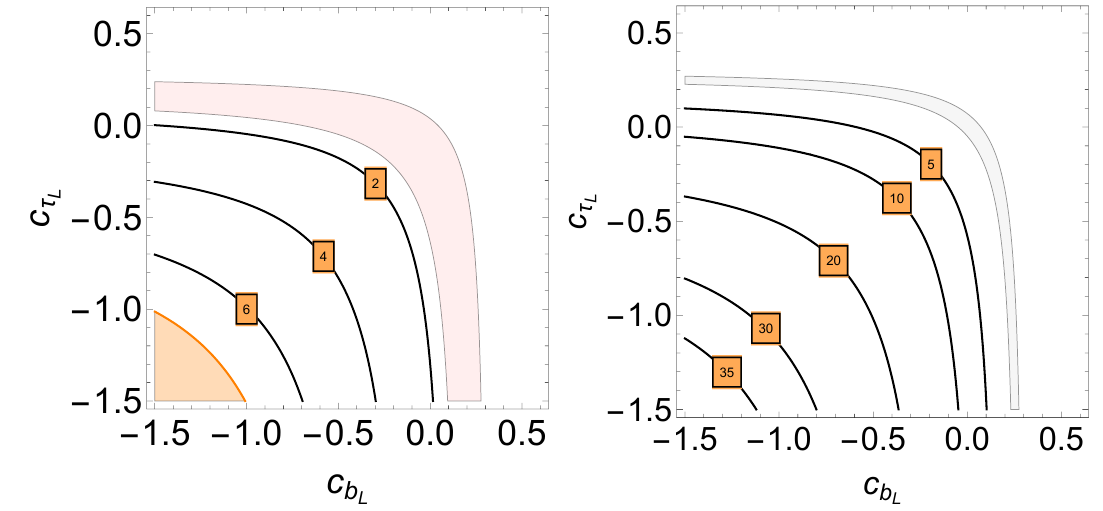
Figure 14 . Left panel: region in the plane ( c b ; c (cid:28) ) that accommodates R (cid:23) < 7 : 11 (orange region K L L is the excluded regime). We also display as a red band the interval 0 : 7 < R (cid:23) < 1 : 5, which is a K region close to the SM value, and as solid lines the values R (cid:23) = 2 ; 4 ; 6. Right panel: branching K ratio R (cid:28) in the plane ( c b ; c (cid:28) ). The gray band corresponds to the interval 0 : 7 < R (cid:28) < 1 : 5, which K K L L is a region close to the SM value, and the solid lines are the values of R (cid:28) from 5 to 35. We have K considered r = 0 : 75 and c (cid:22) = 0 : L